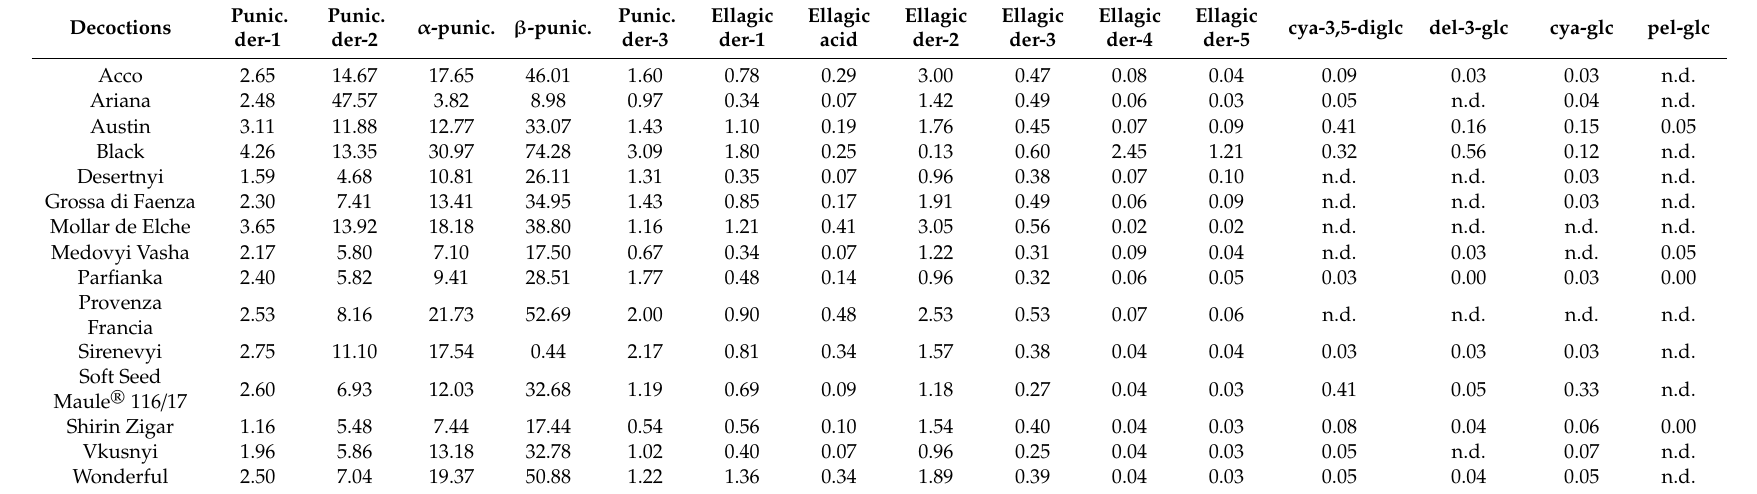
Table 2. Main phenolic compounds evaluated in the produced extracts for decoctions, with data expressed as mg / g. Punic., punicalagin; cya-3,5-diglc, cyanidin-3,5- O -diglucoside; del-3-glc, delphinidin-3- O -glucoside; cya-glc, cyanidin-3- O -glucoside; pel-glc, pelargonidin-3- O -glucoside; n.d.: not detected.